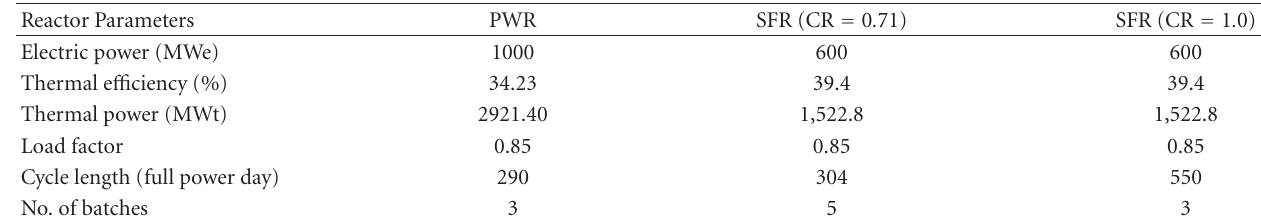
Table 1: Characteristics of the reference PWR and SFR.